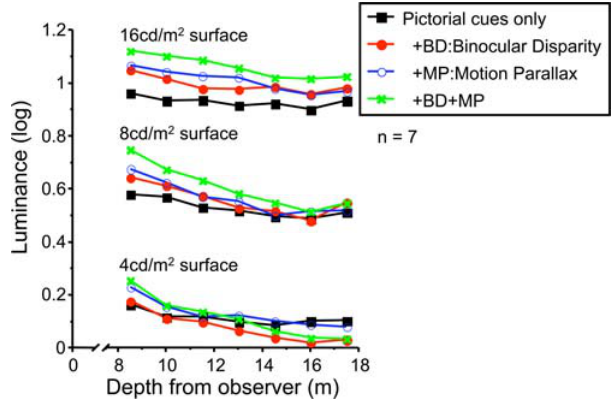
Figure 7. Discounting effects across depth cue conditions for test-surface luminance conditions. The logarithm of luminance for each surface-luminance condition (4, 8, 16 cd/m2) is plotted versus depth for each of the depth cue conditions like in Figure 6.